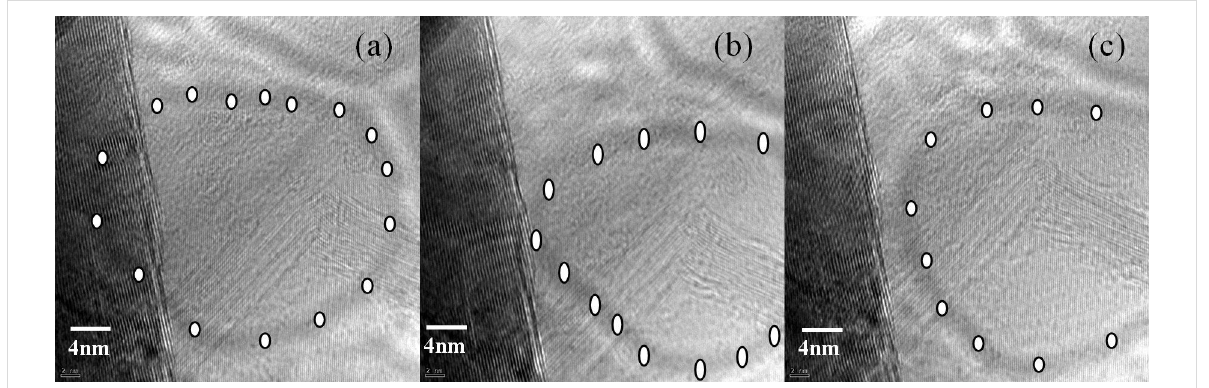
Figure 4: (a–c) TEM images of BNNSs with ring-shaped shadow shifting from the edge. All scale bars are 4 nm.